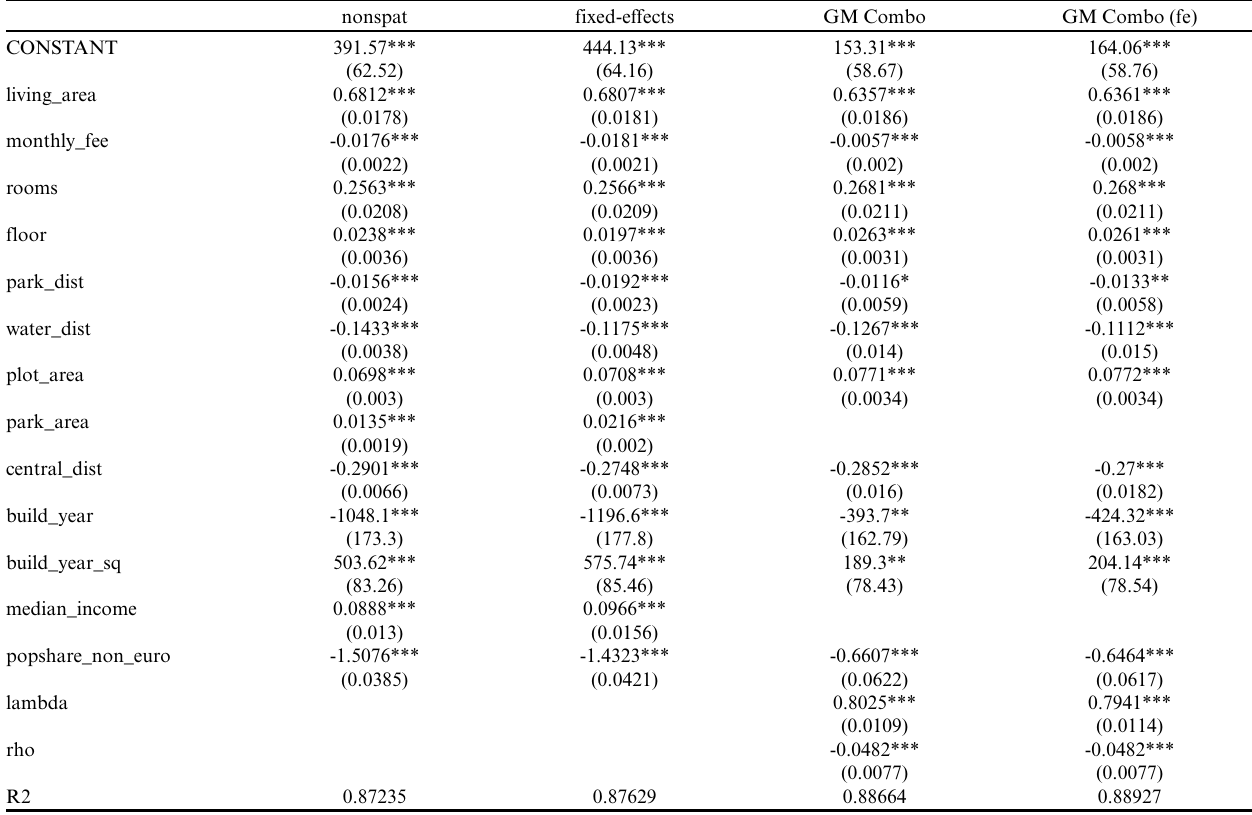
Table 2 . Estimation results for the hedonic price functions for the four different models (nonspatial, fixed effects, GM Combo, and GM Combo with fixed effects, see text for model details). Rows contain parameter estimates and their corresponding standard errors in parenthesis. Last row contains the R2 value for each